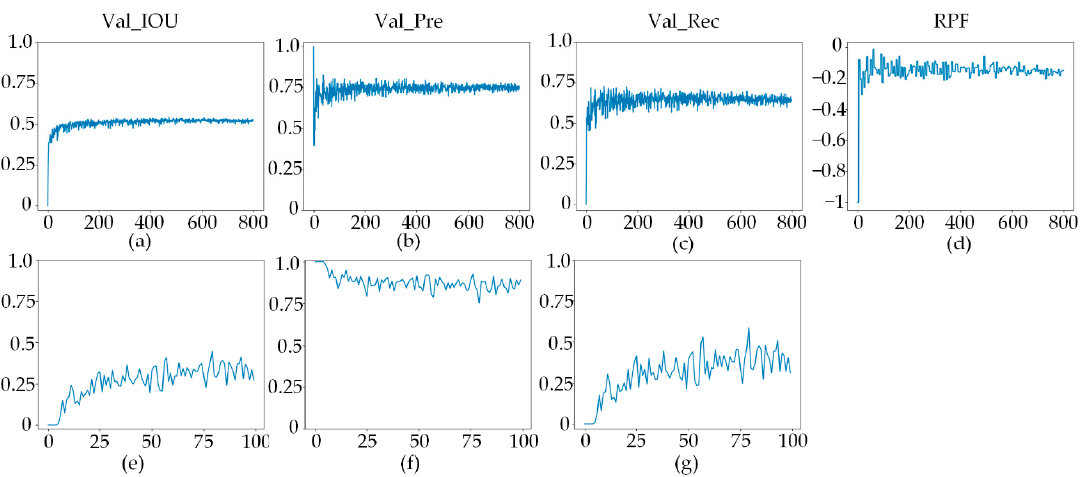
Figure 7. Variations in the precision, recall, and IOU curves during training. ( a – c ) show validation IOU, precision and recall when training whit recurrent adaptive network. ( d ) shows values and changes of PRF during training. ( e – g ) show validation IOU, precision and recall with normal training.